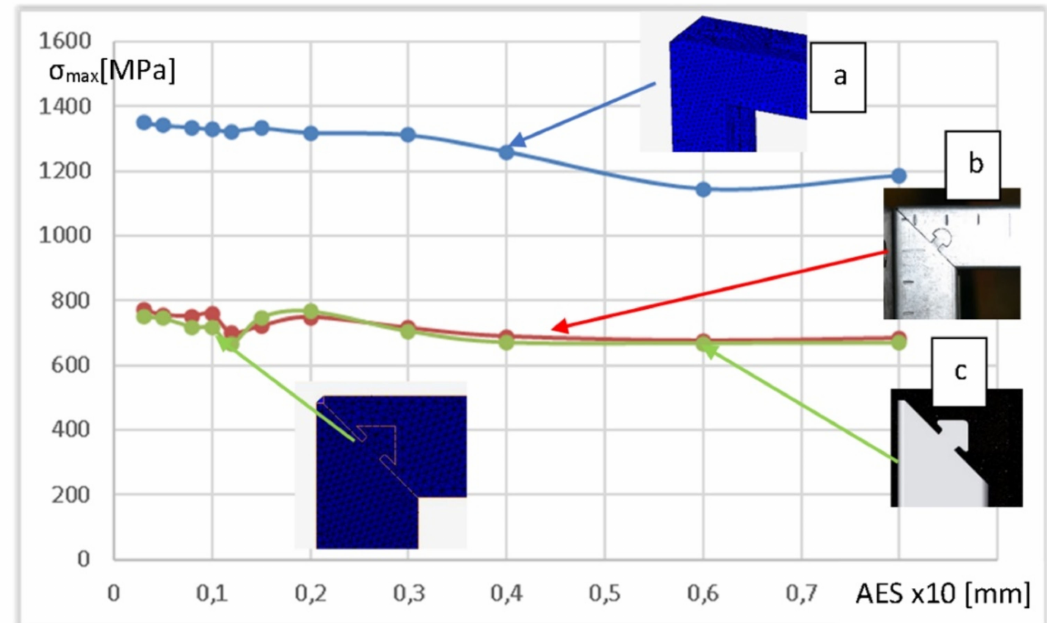
Figure 10. Selected results of the optimization procedure for three numerical models with a profile of 40 mm × 40 mm: console without lock—virtual strut ( a ); console with semicircular shape lock ( b ); console with arrow lock ( c ).